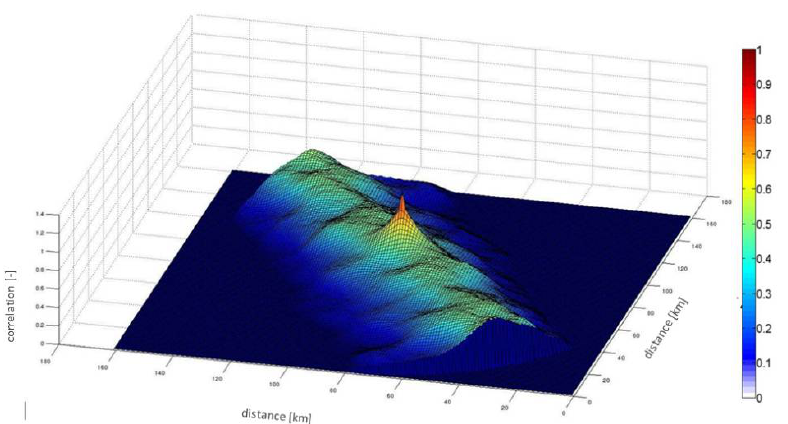
Figure 4. Example of empirical 3D local structure evaluated from the radar observation. The values are between 0 (no correlation) and 1 (perfect correlation (located only on the rain-gauge